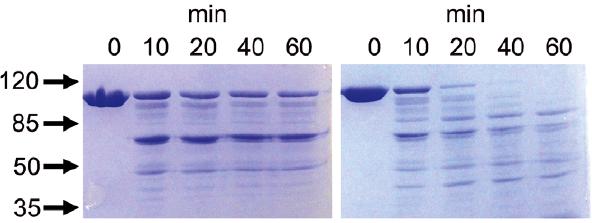
Figure 5. Limited trypsin digestion of purified WT AcrB (left) and AcrB P223G (right). Lanes 2 to 5 were samples taken at 10, 20, 40, and 60 min into the digestion, respectively. Lane 1 was a control sample in which no trypsin was added. WT AcrB was digested slower than AcrB P223G .